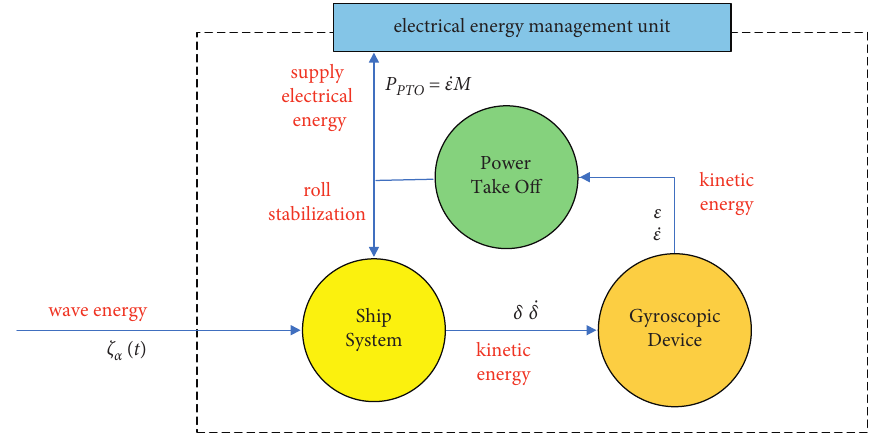
Figure 2: The relationship of energy transfer and conversion in ISWEC Table 1: The parameters of the coupled system.